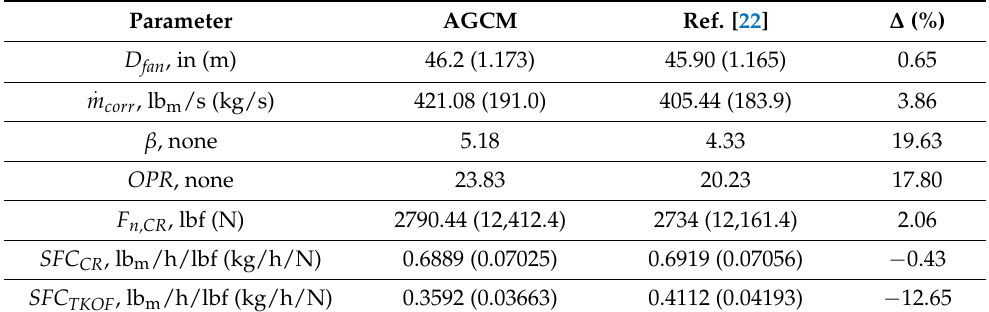
Table 10. Performance absolute levels comparison (CF34-8C5B1 engine prediction, AGCM vs. [22]). Parameter